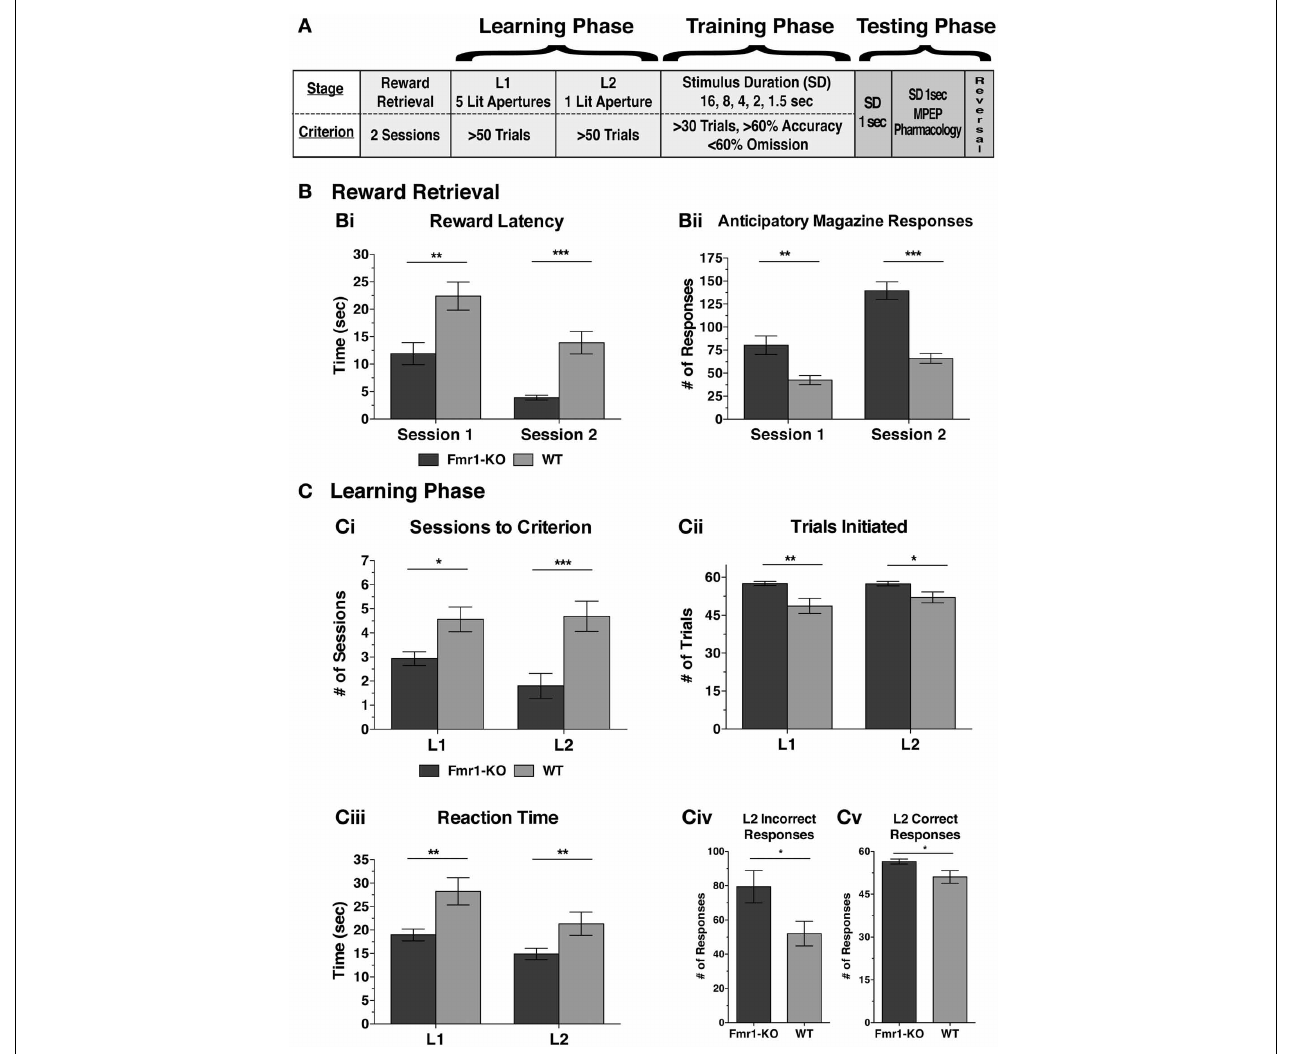
FIGURE 2 | Fmr1 -KO mice progress faster during the activity- dependent learning phase of the 5-CSRTT. Overview of the sequence of learning, training, and testing phases during the 5CSRTT (A) . Fmr1 -KO mice reacted more quickly to the illuminated magazine (Bi) with more anticipatory responses (Bii) during both reward retrieval sessions. Fmr1 -KO mice achieved criterion in fewer sessions than WT during both learning phase 1 (L1) and 2 (L2) (Ci) , and initiated significantly more trials at both L1 and L2 (Cii) . Fmr1 -KO mice reacted number of correct responses in both groups ( Figure 4A {2-way repeated measurements ANOVA [Training phase effect F ( 5 , 145 ) = 16 . 73, p < 0 . 0001], [Genotype effect F ( 1 , 29 ) = 1 . 134, p = 0 . 30], [Interaction effect F ( 5 , 145 ) = 1 . 841, p = 0 . 109]}). Correlating the correct performance of individual mice at SD16 with all sub- sequent stages revealed that individual WT mice performed consistently from one training phase to the next ( Figure 4B [Pearson correlation coefficient: SD8 0.814 ( p = 0 . 0001), SD4 0.648 ( p = 0 . 0067), SD2 0.618 ( p = 0 . 014), SD1.5 0.313 ( p = 0 . 237), SD1 0.6541 ( p = 0 . 008)]). However, even though by the end of training Fmr1 -KO mice as a group performed similarly